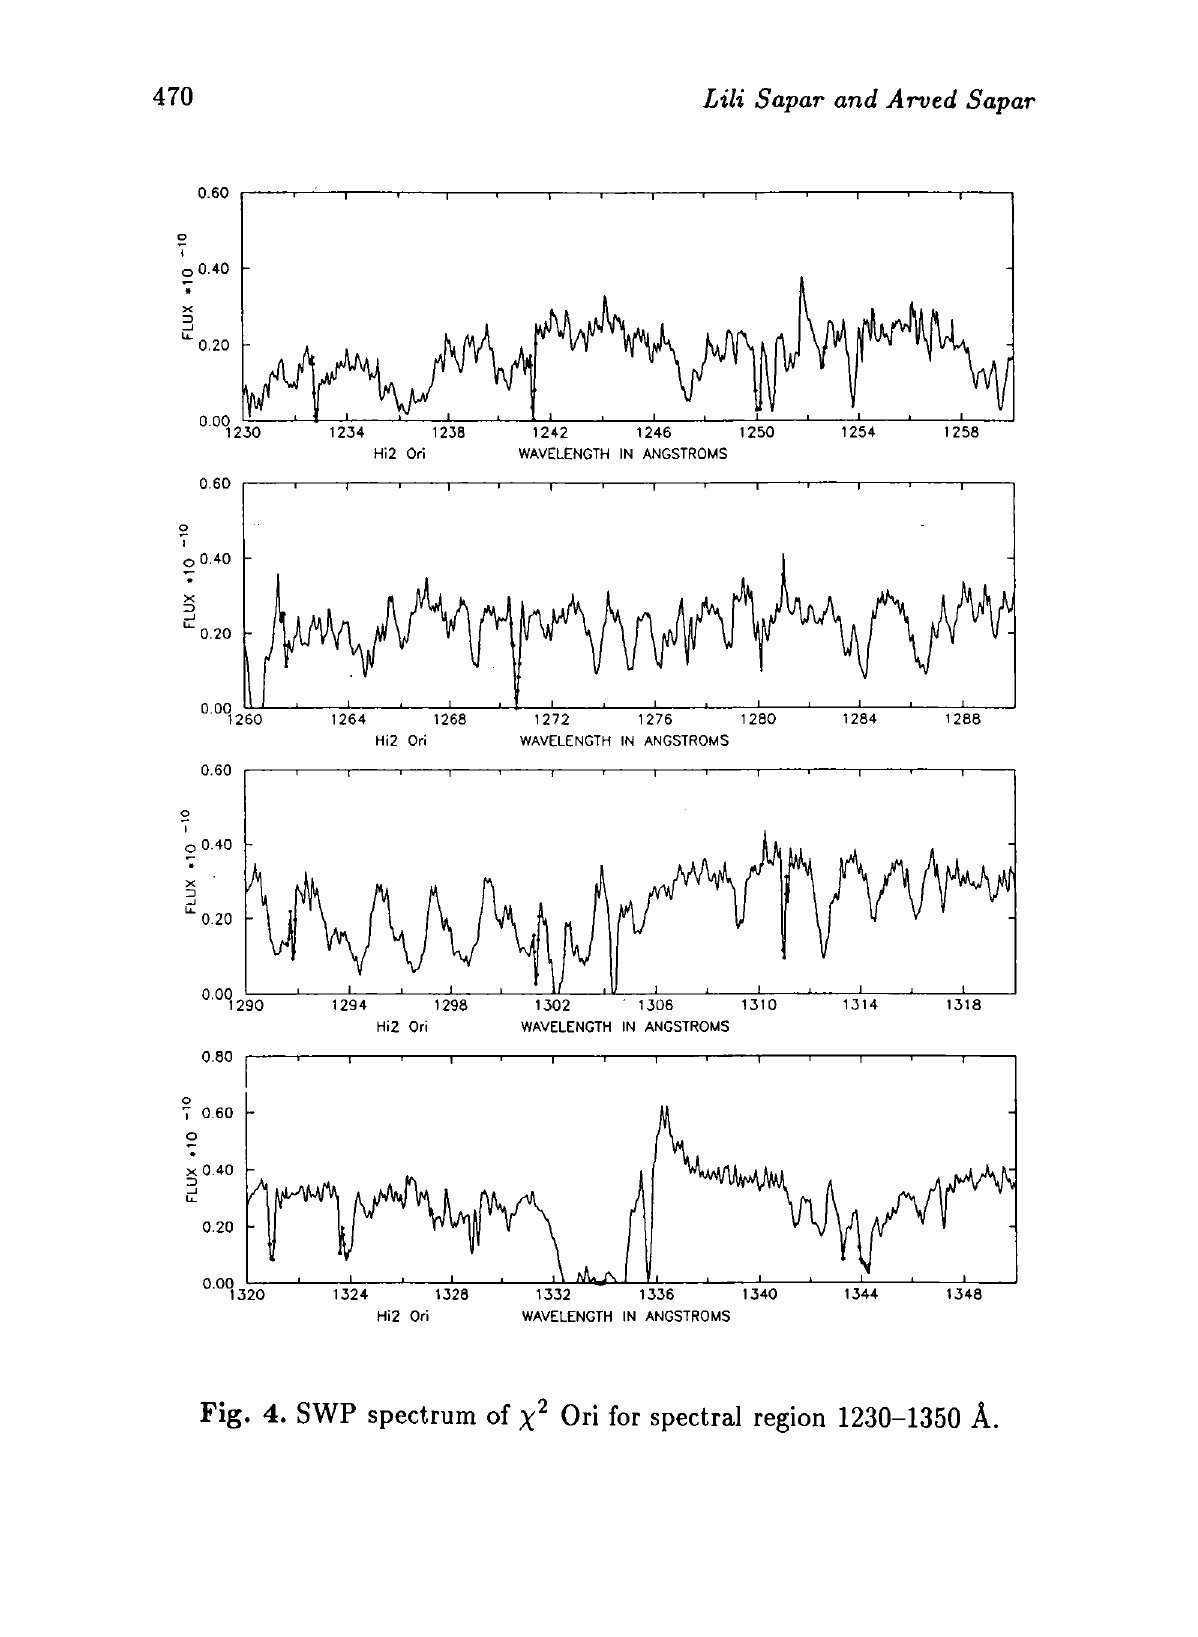
Fig. 4. SWP spectrum of Ori for spectral region 1230-1350